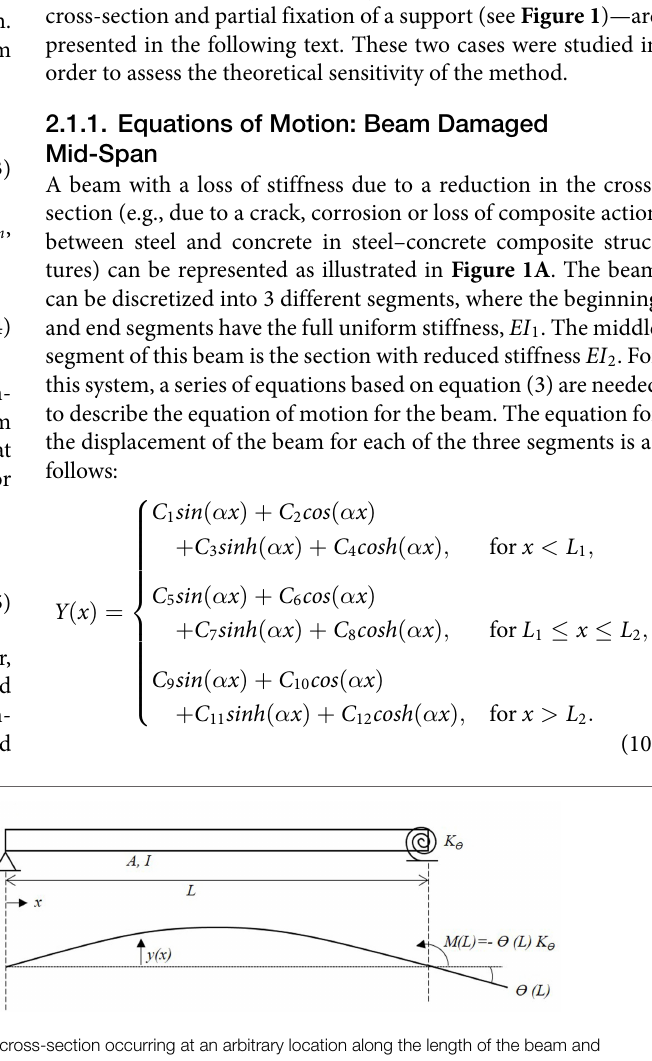
Frontiers in Built Environment |